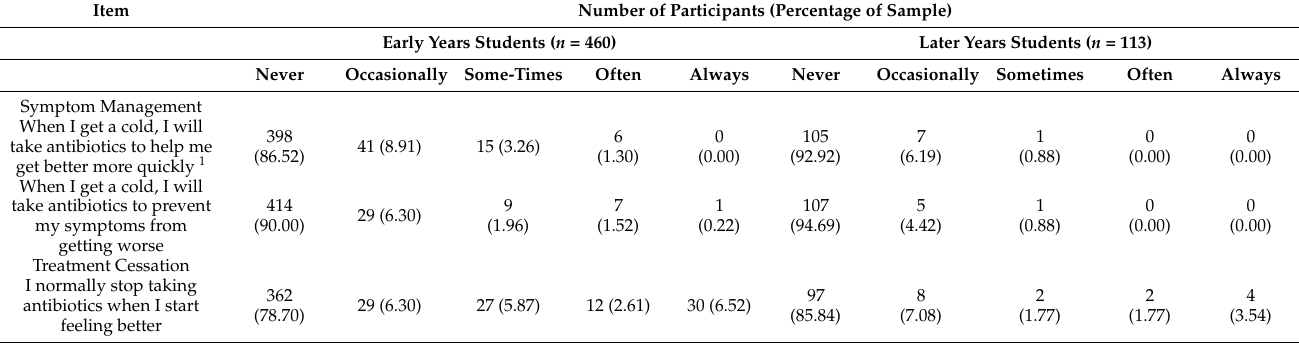
Table 2. Frequency of self-reported behaviors.